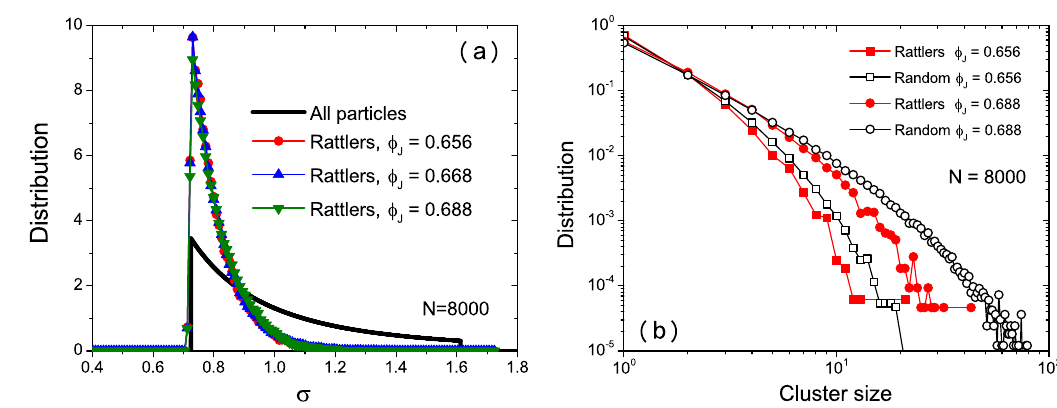
Figure 6: (a) Diameter distribution for all particles, f ( σ ) , and diameter distribution for rattlers ( σ ) . (b) Cluster size distribution for the rattlers (closed symbols), compared to the only, f R same fraction of randomly selected particles in the same packings (open